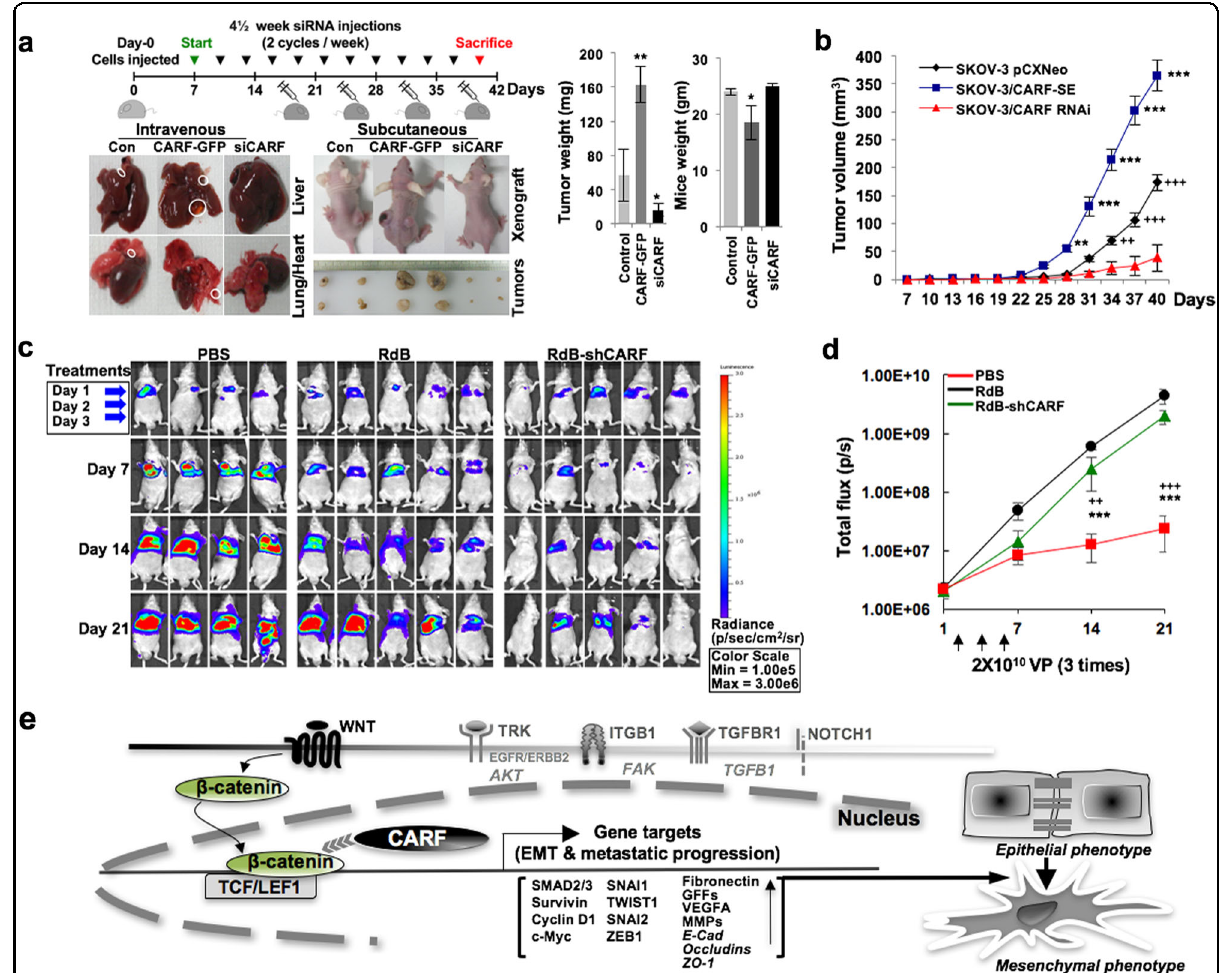
Fig. 7 CARF knockdown attenuates tumor metastases in xenograft models. a Schematic diagram showing regime of nude mice xenograft assays. b Tumor volumes of control, CARF-enriched, and CARF-compromised xenografts. c , Luciferase activity of orthotopic xenograft tumors in mice systemically treated with PBS, RdB, or RdB-shCARF; luciferase intensity and its scale bar are shown on the right. d Quantitation plot showing total fl ux (p/s) values (tumor size) retrieved from PBS, RdB, or RdB-shCARF groups on 7, 14, and 21 days. e Schematic model showing role of CARF in EMT progression, it stimulates nuclear localization of β -catenin instigating activation of several key transcription factors and gene targets that